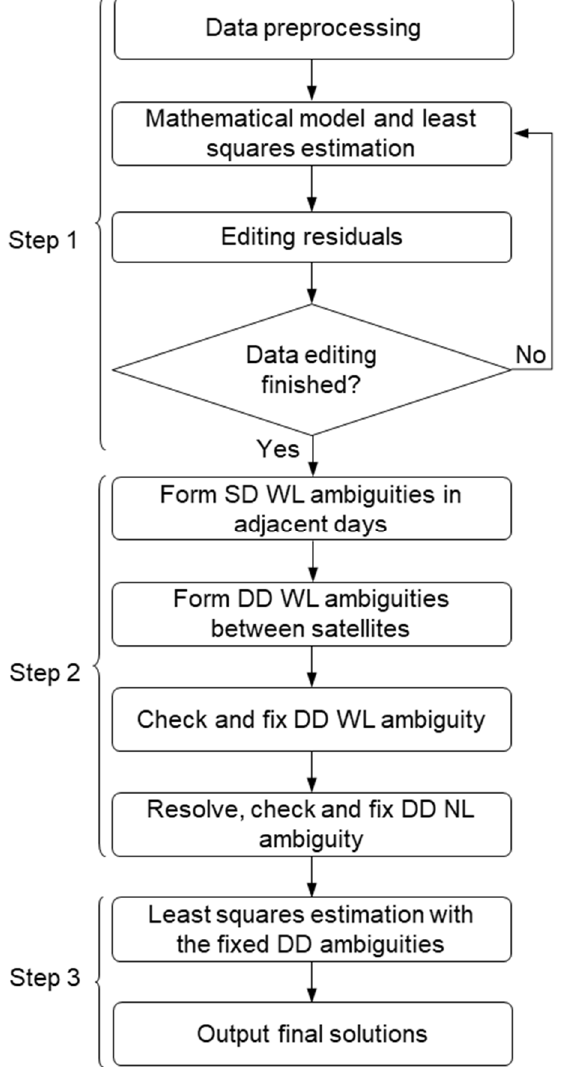
Figure 2. Flowchart of data processing.